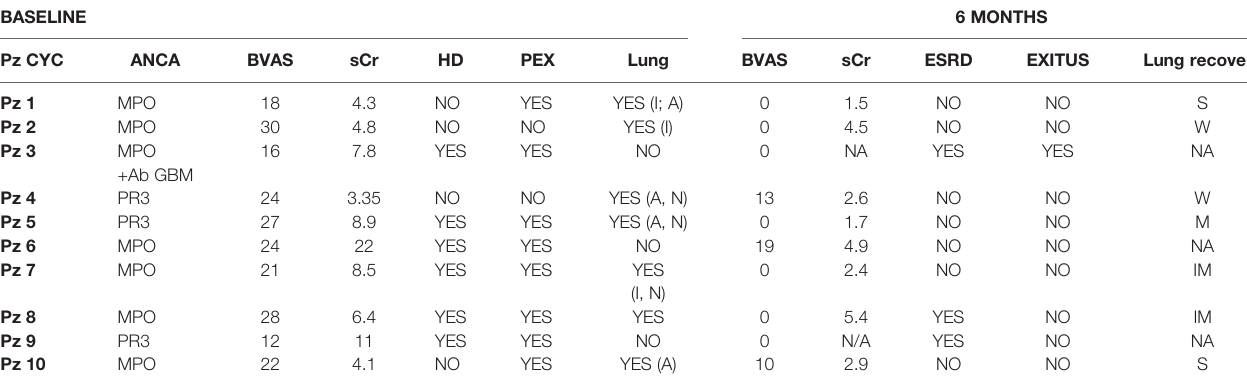
TABLE 3 | Control group parameters at baseline and at 6 months after induction with cyclophosphamide (CYC).